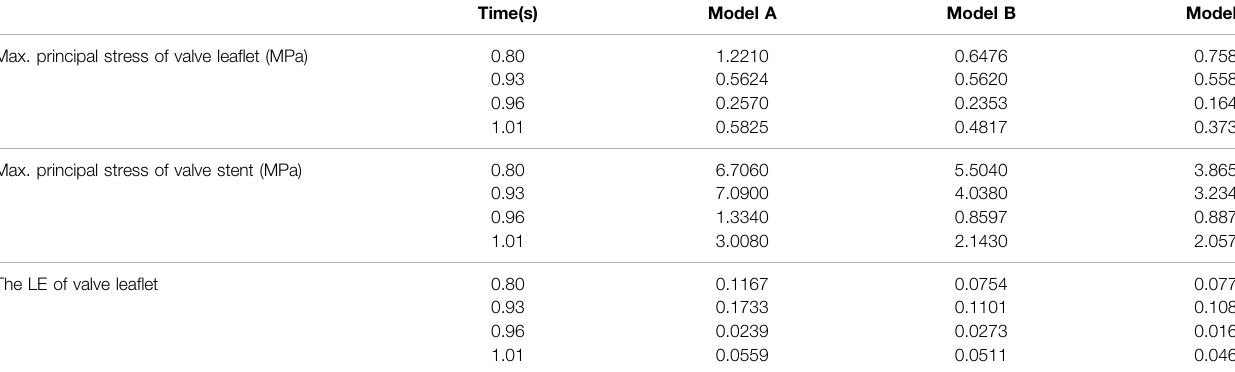
TABLE 3 | The maximum principal stress of the valve lea fl et and valve stent, the LE of valve lea fl